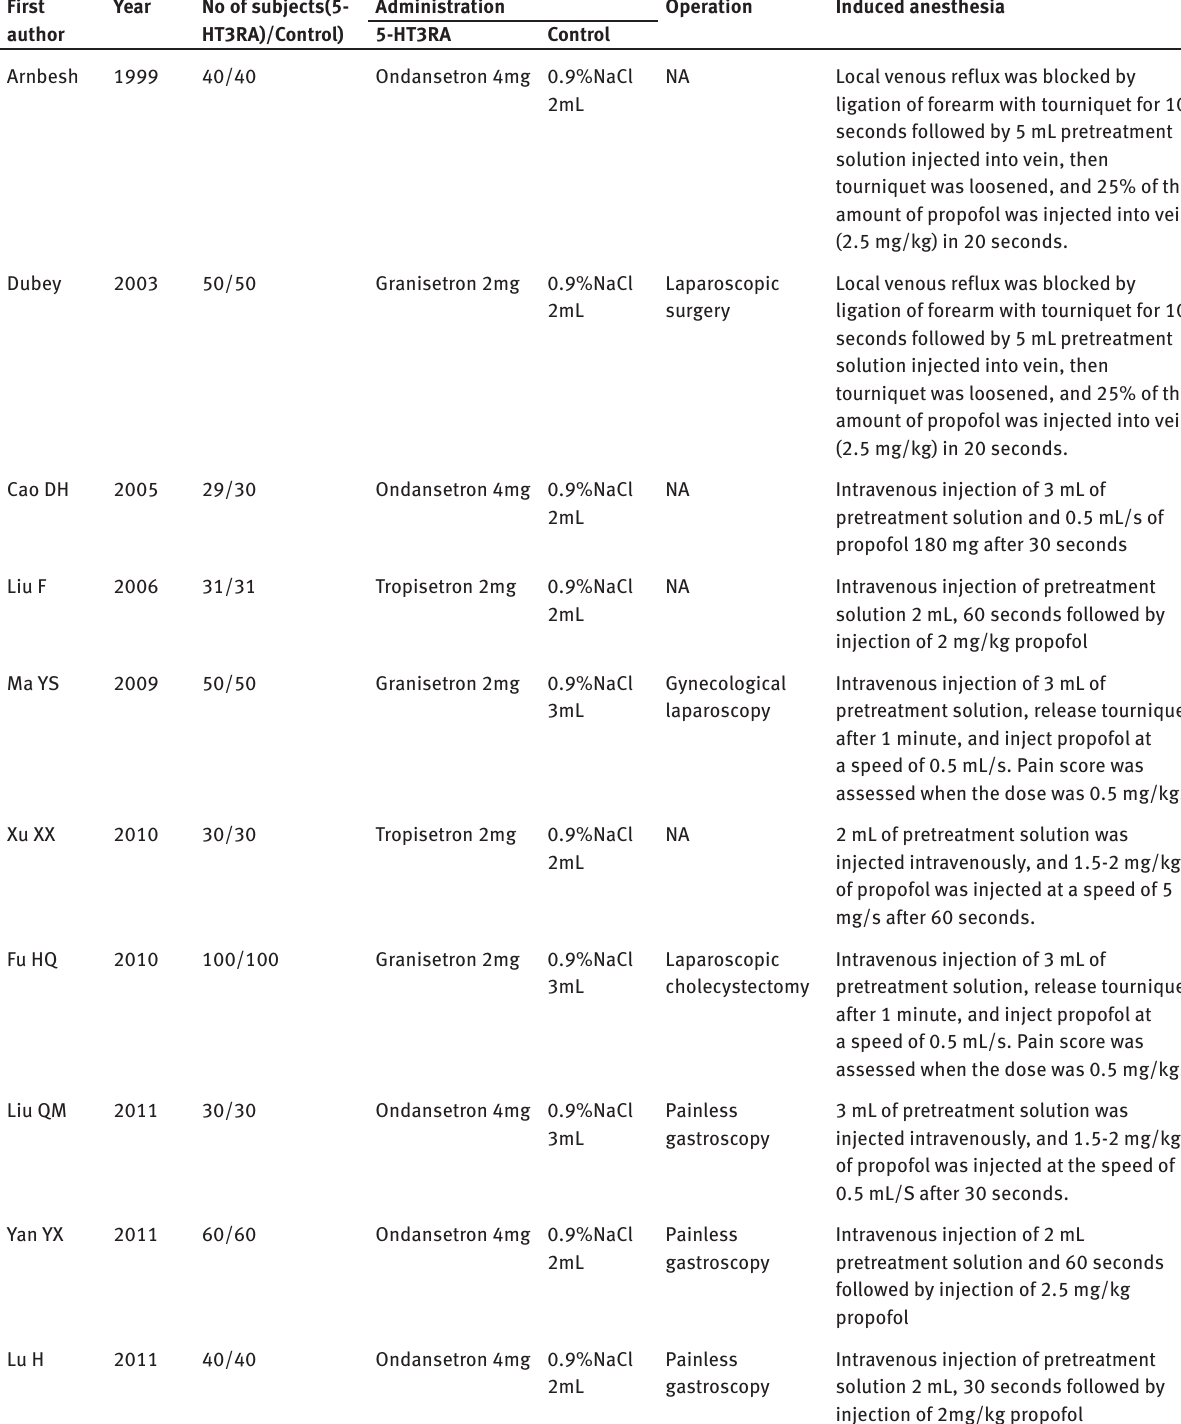
Table 1: Study design and cohort characteristics of included